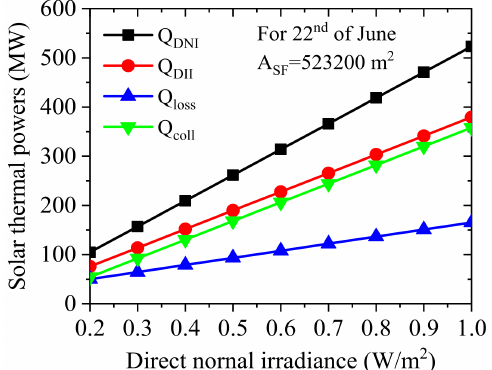
Figure 11. Effect of variation of DNI on the operation performance of the solar field: ( Q DNI is the DNI on an aperture area of the solar field; Q DII is the heat gain of collector from DII; Q loss is the heat loss of collector; Q coll is the heat absorbed in the solar field by the HTF).